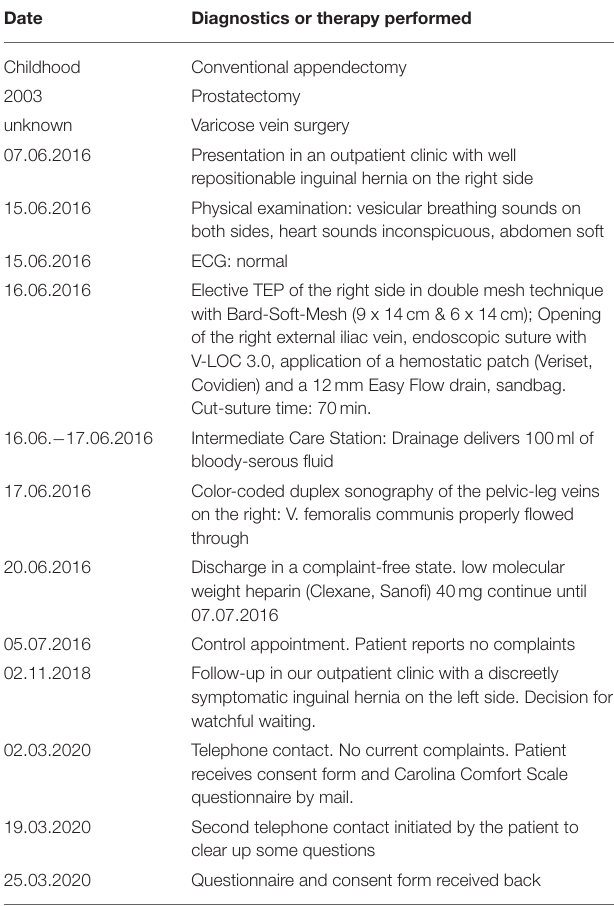
8 mmHg to check the stability of the suture, followed by mesh placement of a 15 x 12 cm large pore monofilament